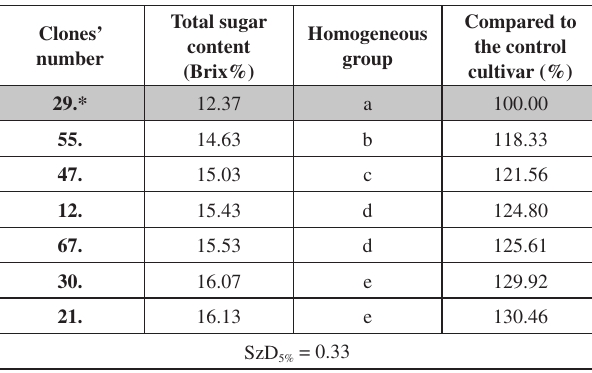
Table 8. Water-soluble total sugar content (Brix%) of Lycium genotipes in 2011